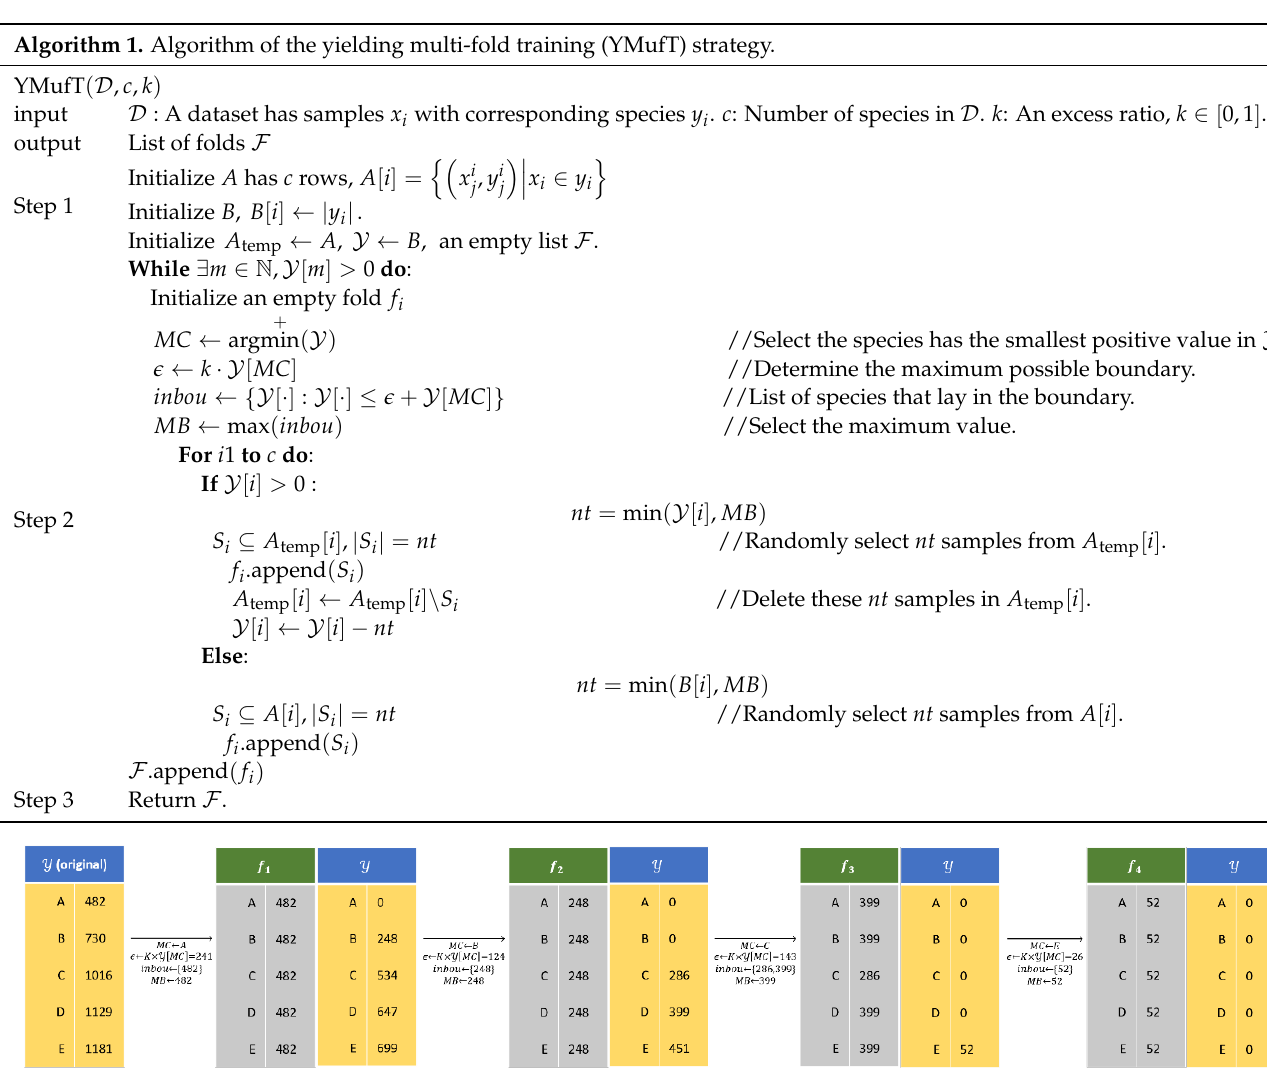
Figure 8. Illustration of the YMufT strategy, with 𝑘 = 0.5 . The original dataset contains 5 species: A, B, C, D, and E.